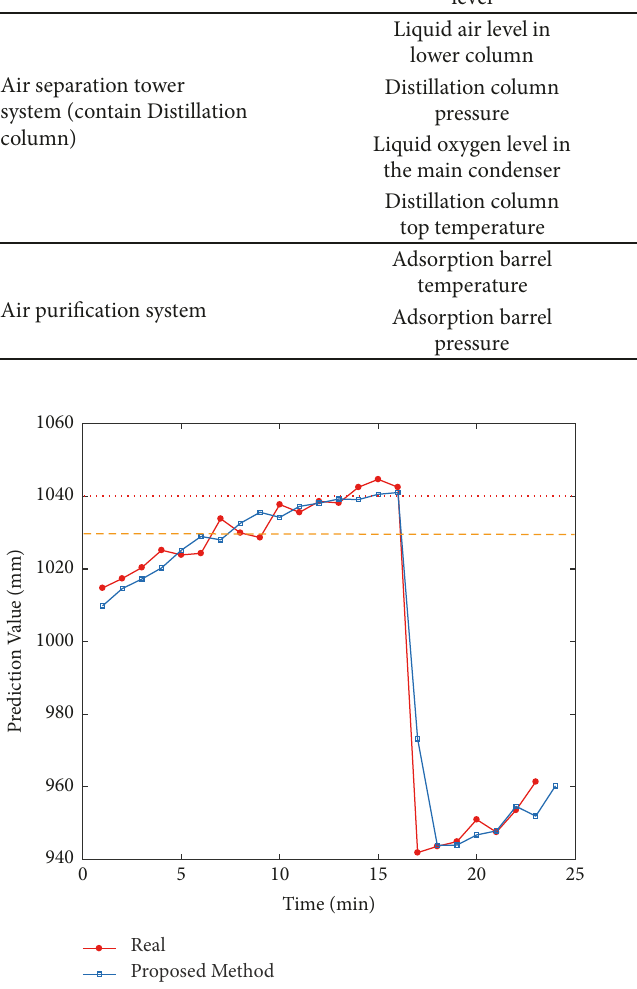
Figure 11: Real-time prediction and display of key parameters.